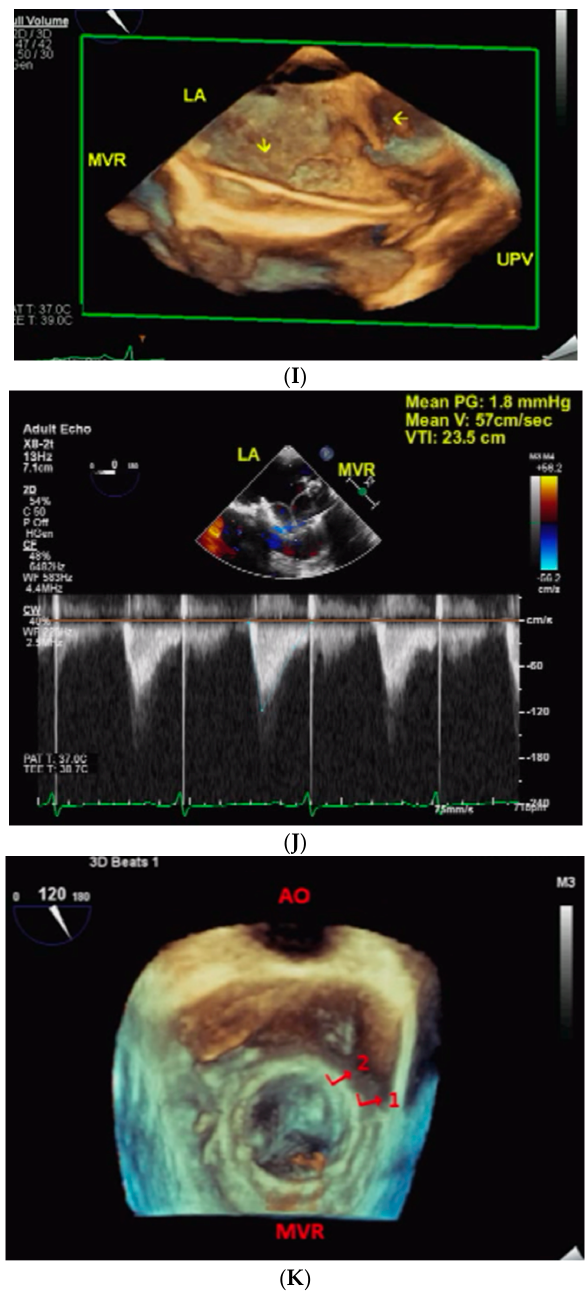
Figure 1. ( A – K ), Video S1. 78-year-old female with severe bioprosthetic mitral valve stenosis (Case 10). Pre-procedure. Two-dimensional transthoracic echocardiography with color Doppler guided continuous wave Doppler in ( A ) shows a mean pressure gradient (PG) of 14 mmHg across mitral valve replacement (MVR) consistent with severe stenosis. Two-dimensional transesophageal echo- cardiography ( B , C ) using the same technique as in ( A ) shows a mean pressure gradient of 13.1 mmHg across MVR also consistent with severe stenosis in ( B ). Turbulent flow across MVR as well as a thrombus (TH) in the left atrial appendage (LAA) and adjacent left atrium (LA) body are demonstrated in ( C ). Live/real-time three-dimensional transesophageal echocardiography ( D – G , Video S1). The arrow in ( D ) points to the MVR orifice which measures 0.72 cm 2 in multiplanar re- construction (MPR) mode consistent with severe stenosis. Viewing the LA body en face by cropping